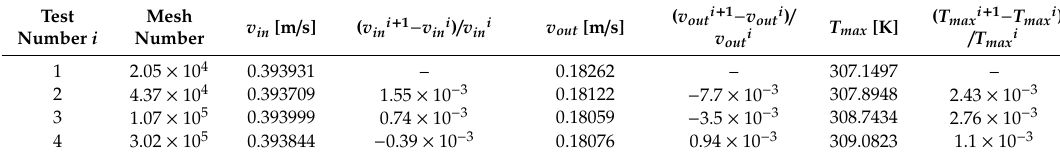
Table 5. Example of grid independence